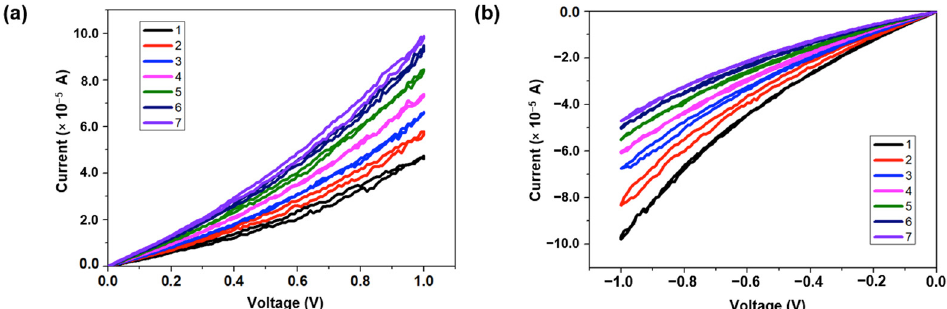
Figure 3. Current–voltage characteristics of the Ta/EV(ClO 4 ) 2 /BFPA-F/Pt memristor when subjected to ( a ) consecutive positive voltage sweeps (0 V → 1 V → 0 V) and ( b ) consecutive negative voltage sweeps (0 V → − 1 V → 0 V). Small voltages of 0.2 V and − 0.2 V are used to read the positive and negative current responses, respectively.